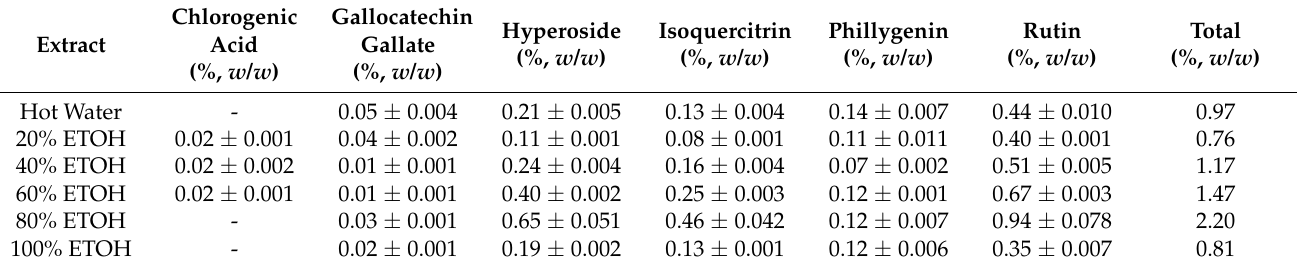
Table 3. Content of biomarkers in hot water and ethanolic extracts from Camellia japonica